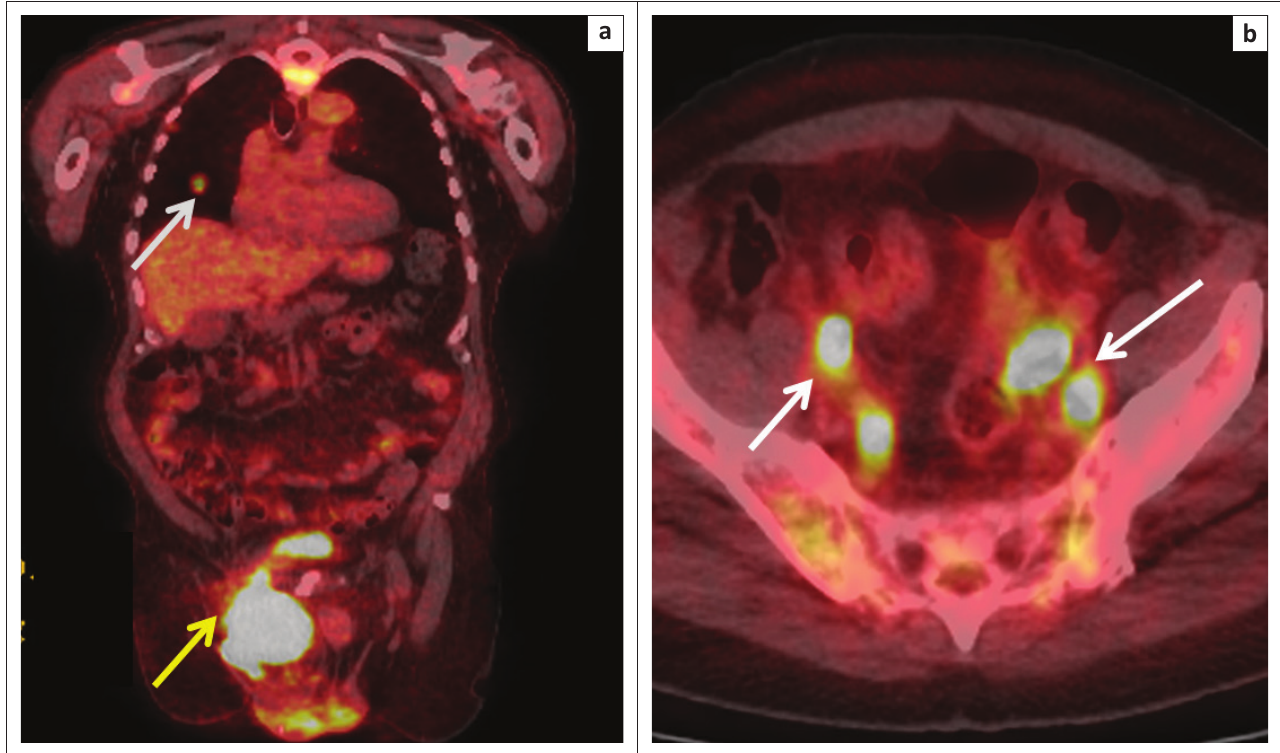
FIG URE 2: (a) Coronal 18-fluoro-D-glucose positron emission tomography/computed tomography (PET/CT) fusion image shows intense hypermetabolic activity (standardised uptake value [SUV] max 28) in the right inguinal mass (yellow arrow). A few metabolically active nodules were present in both lungs, of which one is shown in the same picture (white arrow). (b) Axial PET/CT fusion image demonstrating multiple metabolically active lymph nodes in the pelvis (white arrows) with SUV max of